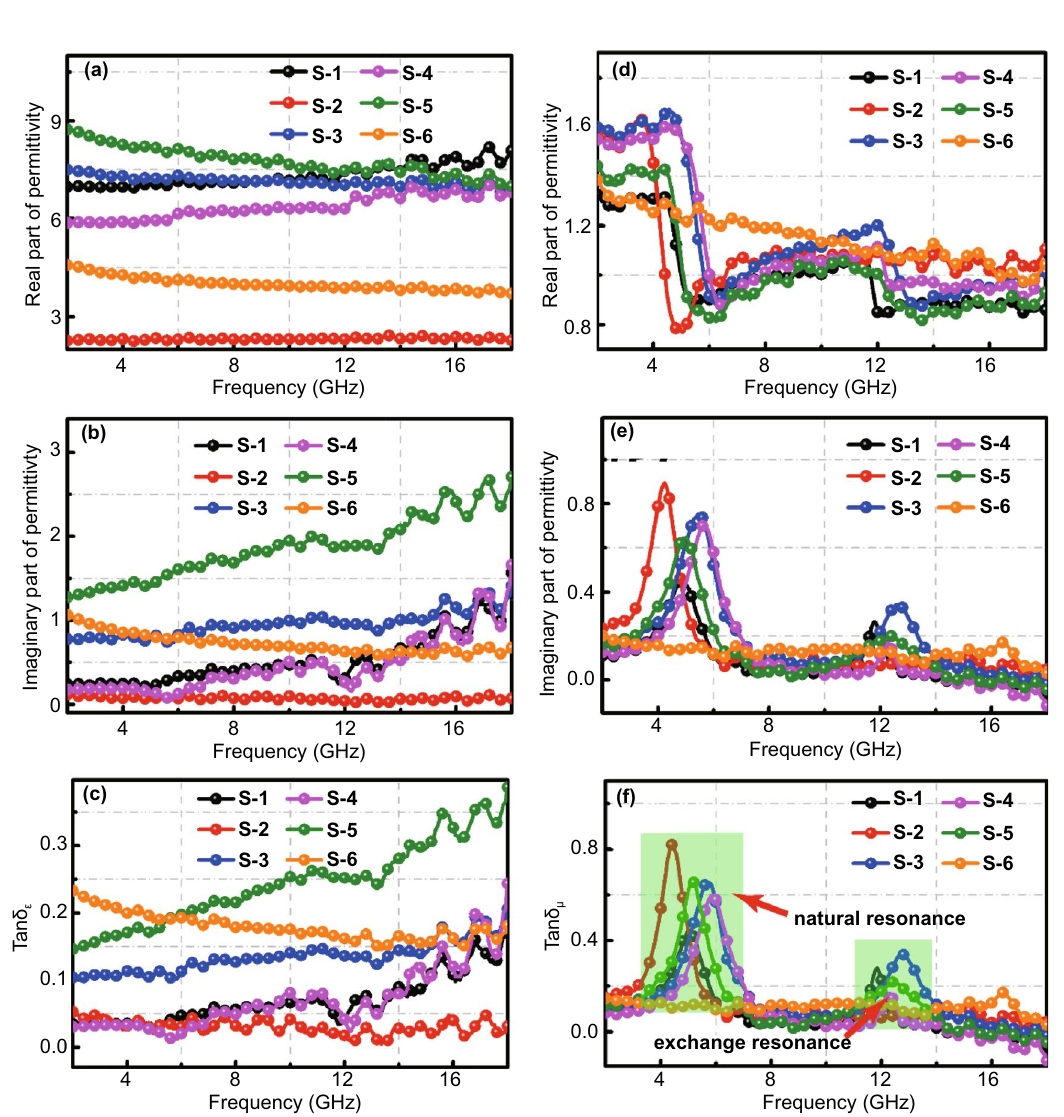
Fig. 7 a Real part and b imaginary part of complex permittivity of all samples, d real part and e imaginary part of the complex permeability of all samples, c the dielectric loss tangent and f the magnetic loss tangent of all